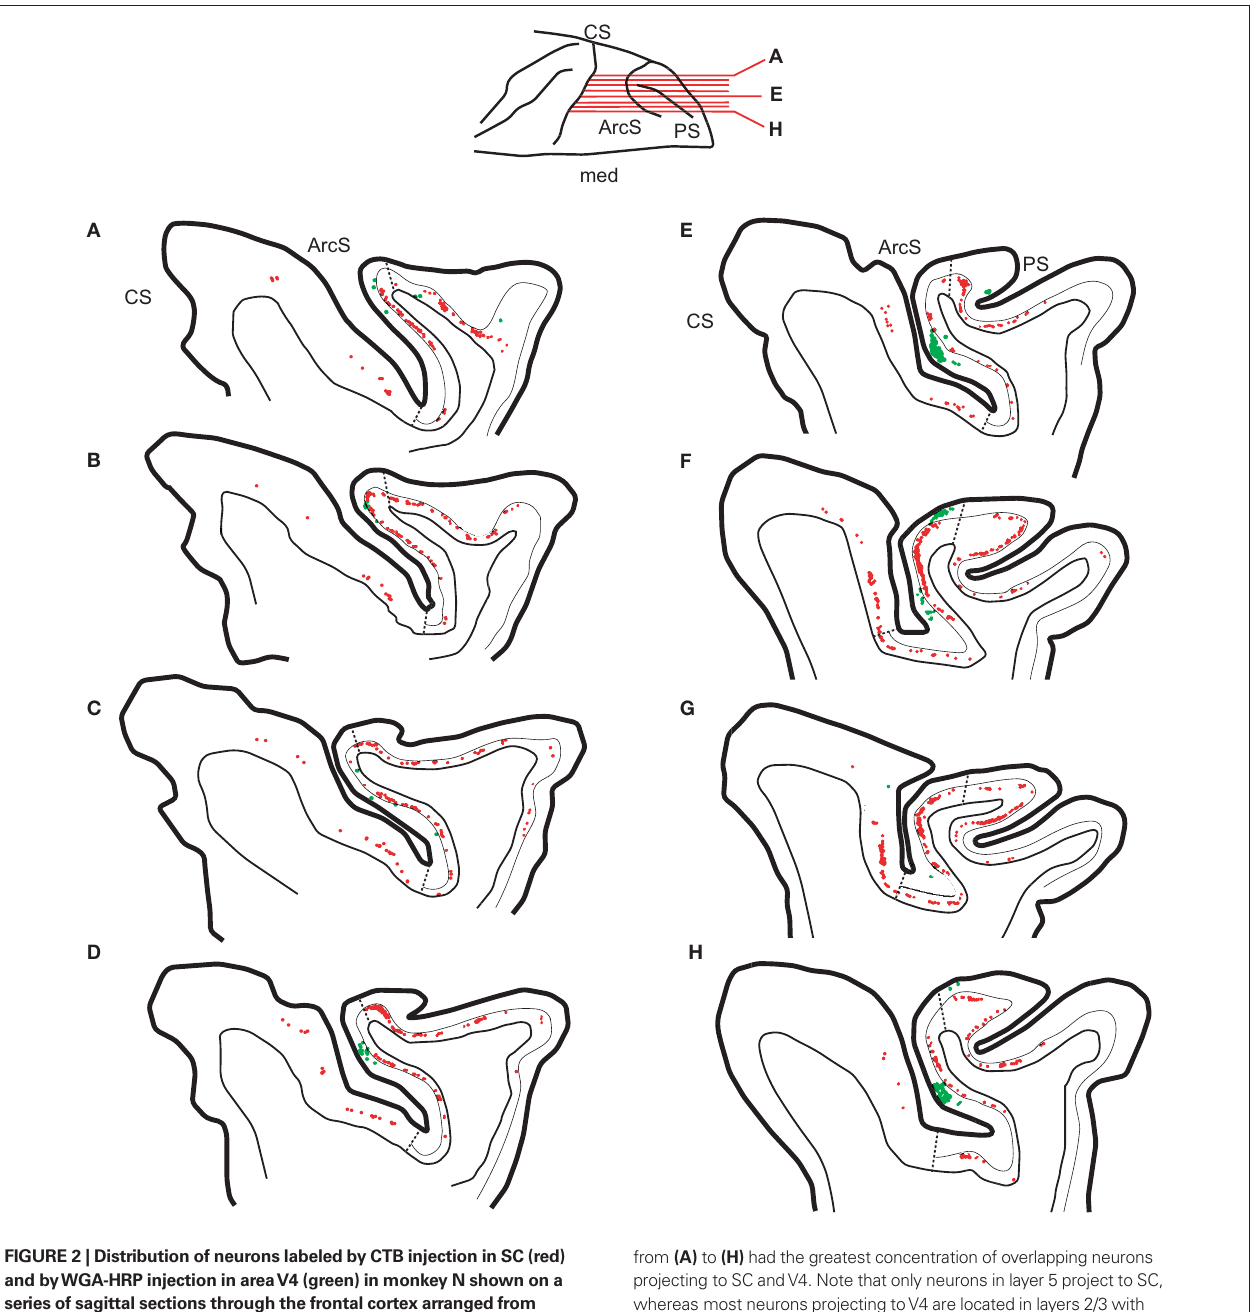
from (A) to (H) had the greatest concentration of overlapping neurons projecting to SC and V4. Note that only neurons in layer 5 project to SC, whereas most neurons projecting to V4 are located in layers 2/3 with very few in layer 5. Sulci abbreviations follow the convention used in Figure